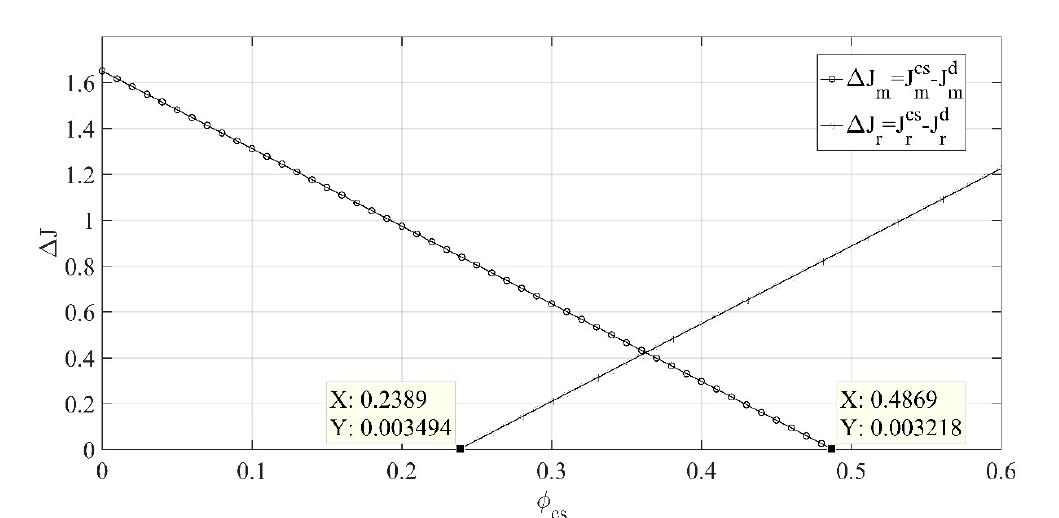
φ on the present value of profits. Figure 1. The effect of φ cs on the present value of profits.